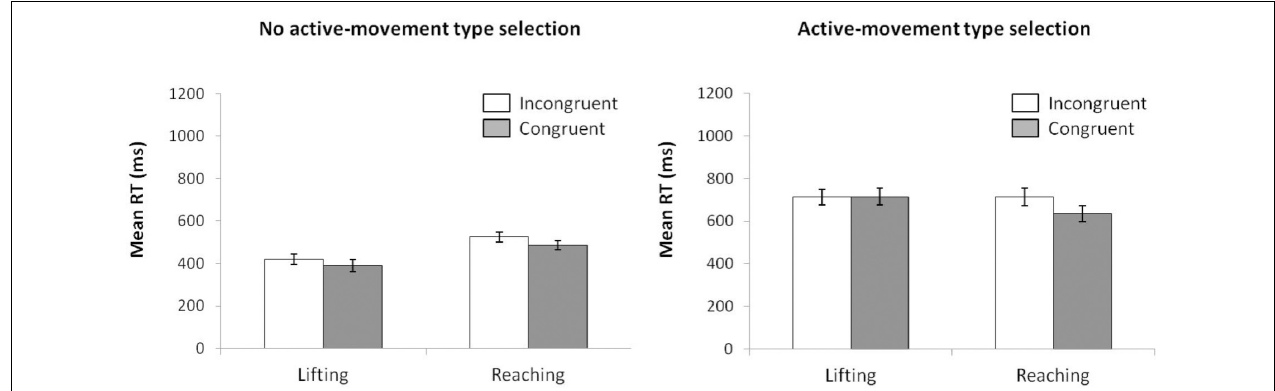
FIGURE 6 | Interactions of movement type selection × movement complexity × congruence, within the no active-movement type selection condition (Left) and active-movement type selection (Right) , with respect to mean reaction time in Experiment 3. Error bars represent the standard error of the mean.